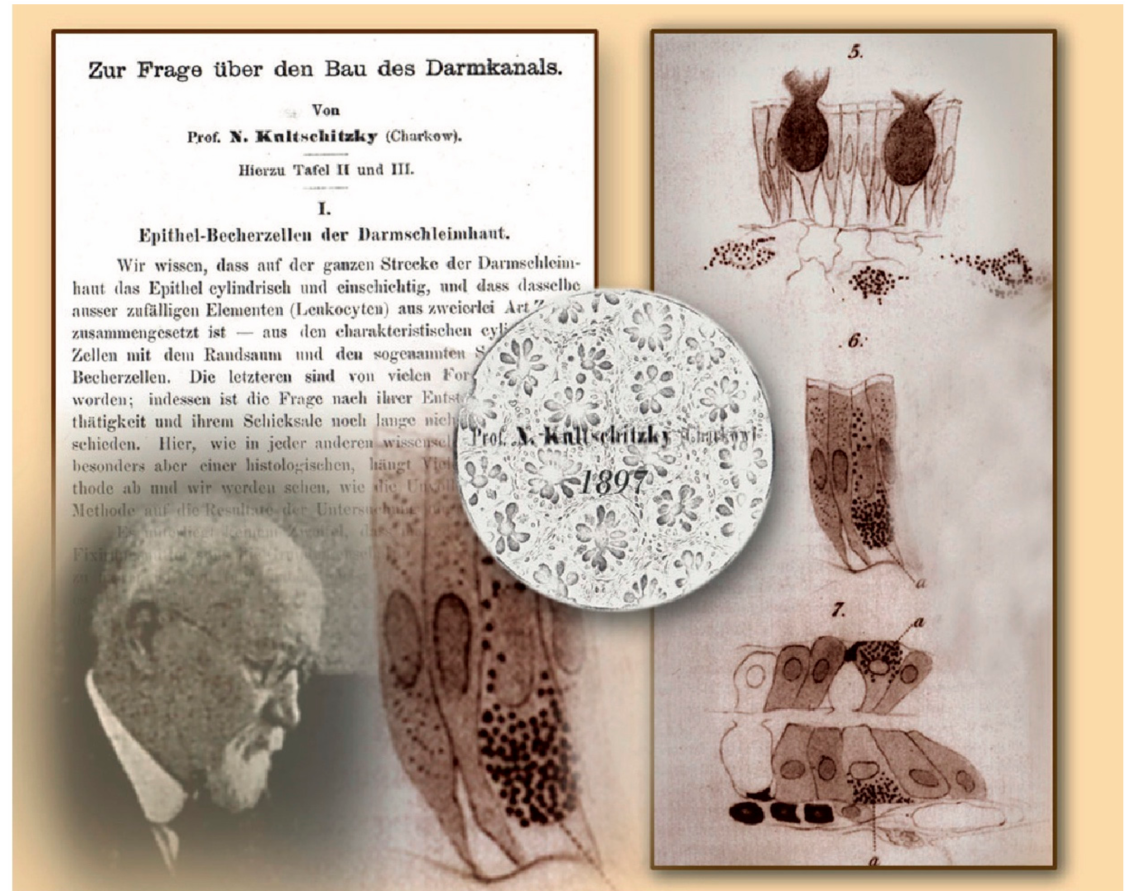
Figure 7. First description of a «unique» cell of the intestinal epithelium (right), made by Nikolai Kulchitsky (bottom left) in 1897. His work Zur Frage über den Bau des Darmkanals was published in Arch Mikr Anat 1897. The Figure is obtained from Drozdov et al., (2008). Reprinted by permission from Springer Nature Customer Service Centre GmbH: Springer Nature, Cell and Tissue Research (License Number 5232431160386, 19 January 2022)